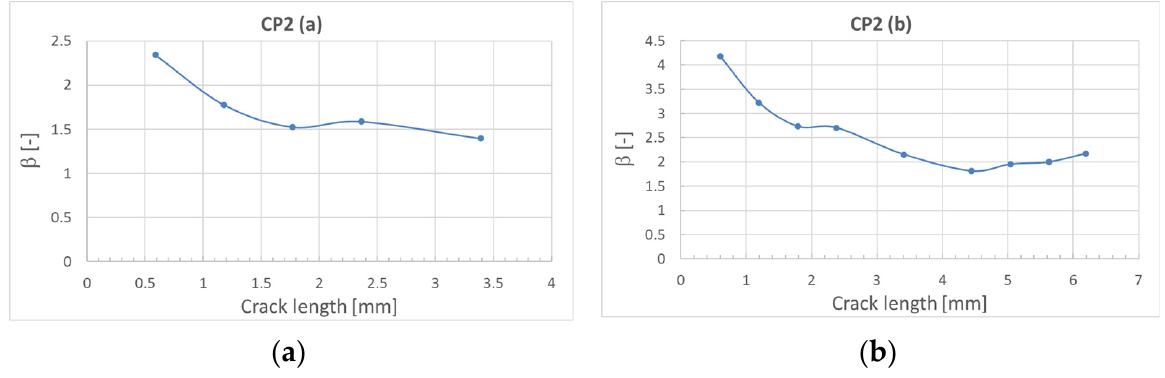
Figure 7. Calculated values of β versus crack length. ( a ) For section a of CP2; ( b ) for section b of CP2.